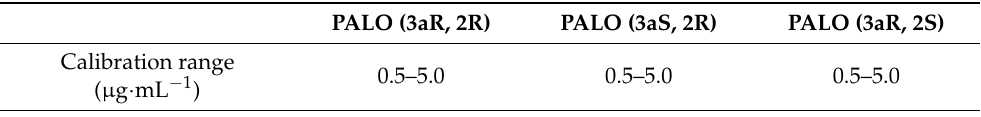
Figure 4. Electropherograms of PALO injection spiked with enantiomeric impurities to different con- centrations. BGE composition is 30 mM STC in 30 mM sodium tetraborate of pH 9.2. Hydrodynamic injection at 10 kPa for 10 s. Detection wavelength: 254 nm. Other CE conditions are the same as in Figure 1. The four peaks from left to right are in the order of PALO (3aS, 2S), PALO (3aR, 2R), PALO (3aS, 2R), and PALO (3aS, 2R). Table 2. Quantitative parameters of the developed method by using 30 mM STC for the analysis of the PALO injection spiked with enantiomeric impurities a